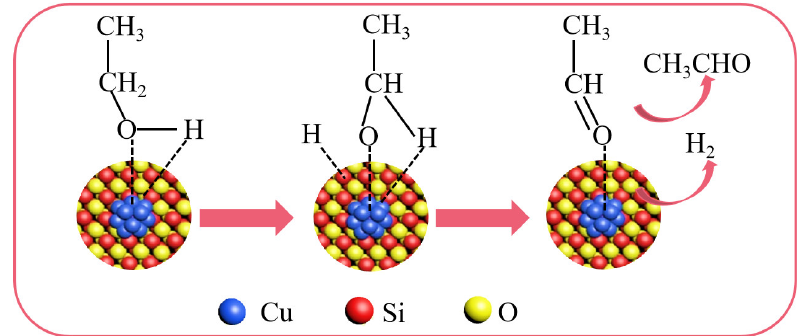
Figure 11. Possible reaction mechanism of ethanol dehydrogenation.